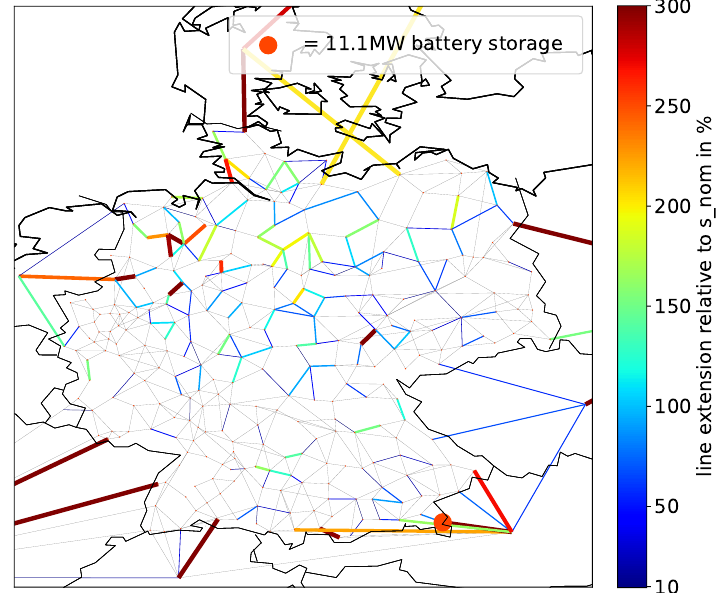
Figure 10. Allocation of grid and storage expansion in the EHV and HV level for the scenario NEP 2035 . s_nom refers to the original nominal thermal limit capacity of each line. A net 300% extension is synonymous with a new optimized capacity of four times the original